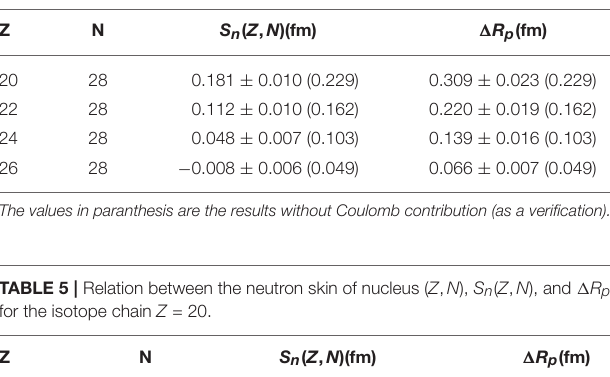
TABLE 4 | Relation between the neutron skin of nucleus ( Z , N ), S n ( Z , N ), and 1 R p of the corresponding mirror pair for the isotone chain N = 28.